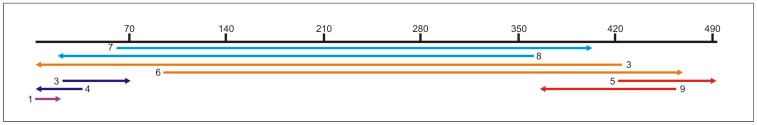
Schematic diagram detailing sequencing of the Gennadius 1889 Bemisia tabaci mtCOI amplicons using primers listed in Table 1.The final 496 bp contig was assembled from five amplicons (primer pairs 1+2; 3+4; 5+9; 3+6; 7+8).